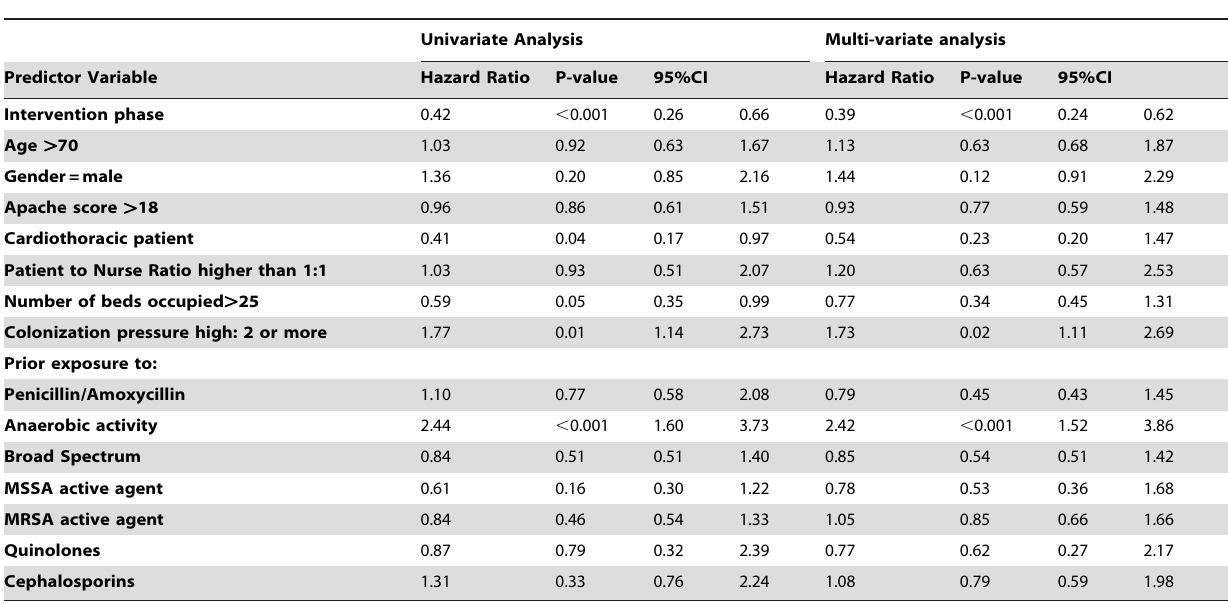
Table 4. Hazard ratios for covariates associated with MRSA acquisition.